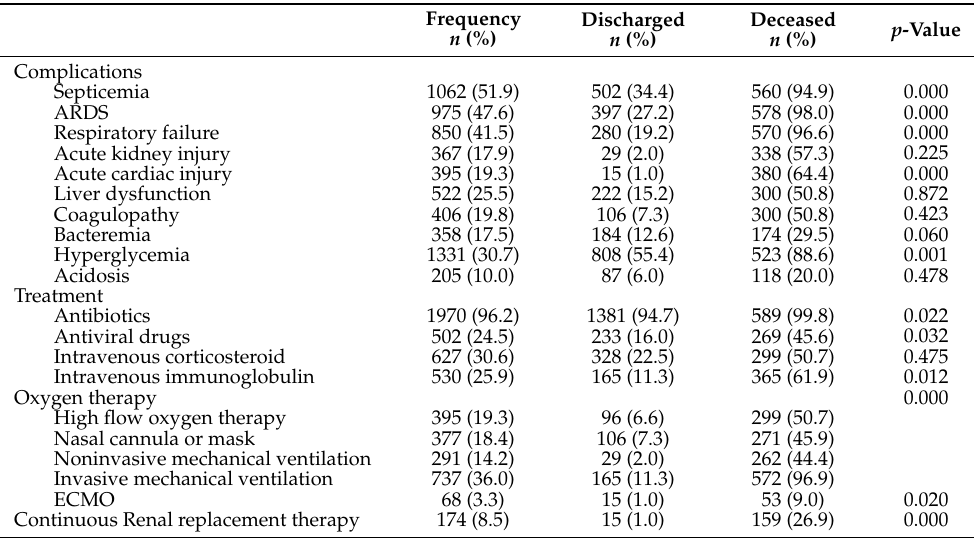
Table 3. Complications and treatment during hospitalization for COVID-19 patients and in-hospital